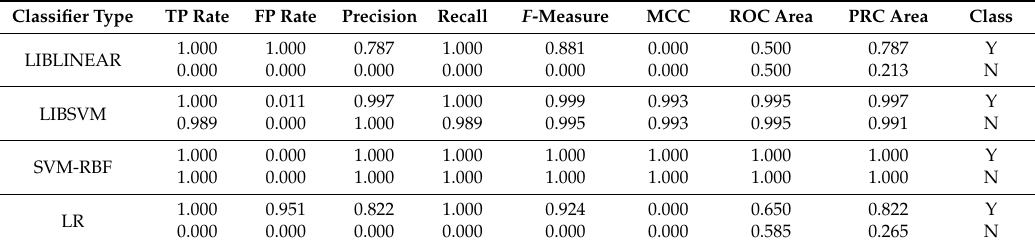
Table 6. Accuracy by class: packets received (yes (Y)/no (N)). LR: logistic regression; MCC: Matthew’s correlation coefficient; PRC: precision–recall curve; ROC: receiver operating